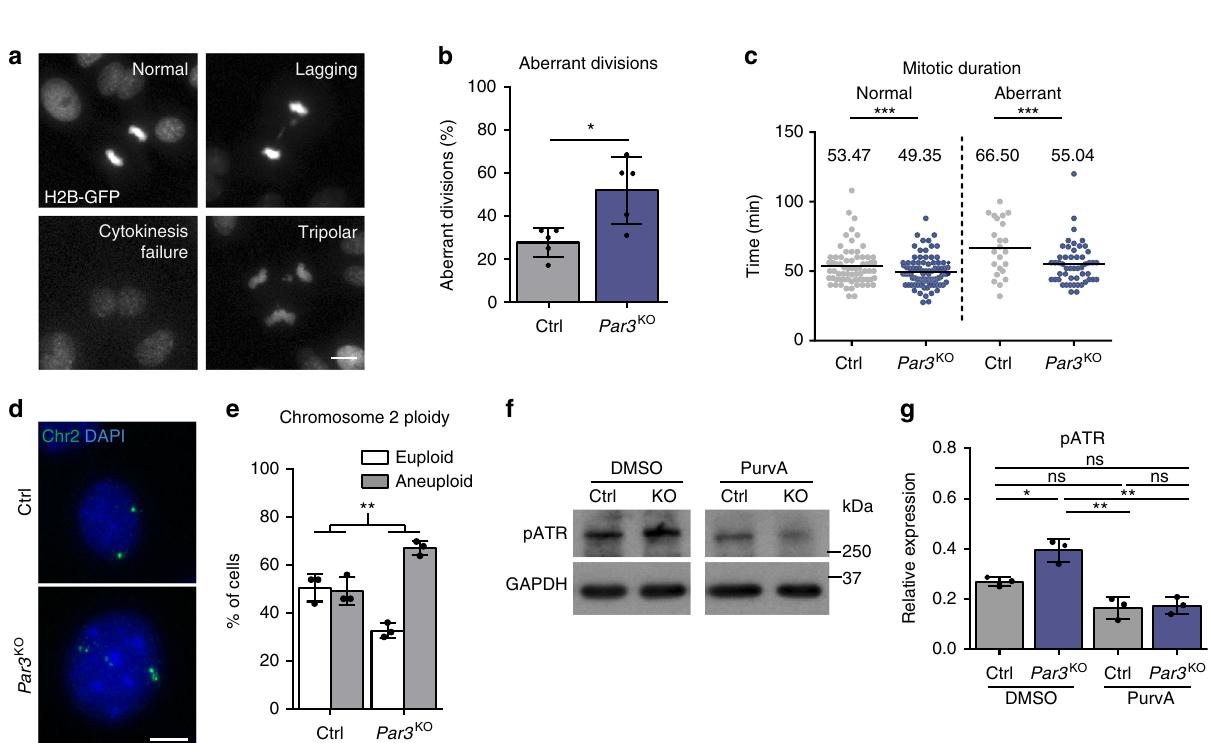
Fig. 2 Par3 ensures mitotic fi delity and genome integrity of keratinocytes. a Representative images of mitotic aberrations observed in time-lapse microscopy of H2B-GFP-expressing keratinocytes (H2B-GFP in gray). Scale bar: 10 µ m. b Quanti fi cation of aberrant cell divisions in primary Par3 KO and control keratinocytes observed in time-lapse microscopy. n = 5 independent experiments, paired two-tailed Student ’ s t -test, * p = 0.0438, mean ± SD. c Quanti fi cation of mitotic duration (Ctrl/normal n = 69 cells, Par3 KO/normal n = 95 cells, Ctrl/aberrant n = 23 cells, Par3 KO/abnormal n = 51 cells; in all cases pooled from three independent experiments). For statistical analysis a nonlinear mixed model using RStudio software was employed, yielding *** p < 0.001. Bar represents mean. d Representative images of iFISH probes targeting chromosome 2. Scale bar: 10 µ m. e Quanti fi cation of d . n = 3 independent experiments, ** p = 0.0028, mean ± SD; two-way ANOVA/Sidak ’ s multiple comparisons test. f Immunoblot analysis of ATR activation in primary Par3- de fi cient and control keratinocytes after treatment with Cdk1 inhibitor Purvalanol A (10 µ M). GAPDH served as loading control. g Quanti fi cation of f . pATR levels were fi rst normalized to GAPDH and then expressed as relative values. n = 3 independent experiments; mean ± SD; two-way ANOVA/Tukey ’ s multiple comparisons test * p = 0.0459, ** p = 0.0026 ( Par3 KO/DMSO vs. Ctrl/PurvA), ** p = 0.0032 ( Par3 KO/DMSO vs. Par3 KO/PurvA). Cropped immunoblot data are shown. iFISH interphase fl uorescence in situ hybridization, Ctrl control, KO Par3 KO, PurvA Purvalanol A, ns non-signi fi Par3 in wild-type keratinocytes (Fig. 3e – g). In agreement, Fig. 4a, b), supporting a role for cortical Par3 upstream of myosin immunoblotting demonstrated a signi fi cant overall reduction in activation. Importantly, active RhoA (RhoA-GTP), but not phosphorylation of MLC2 and of the actin-binding proteins total RhoA, was signi fi cantly decreased following Par3 inactiva- ezrin – radixin – moesin (pERM) (Fig. 3h, i). Moreover, both re- tion (Fig. 3j, Supplementary Fig. 6a, b). This was further asso- expression of Par3-full length (Par3-FL) and membrane-targeted ciated with increased protein expression of the Rho-inhibiting Par3 (Par3-CAAX) were suf fi cient to restore junctional MLC2 protein p190-RhoGAP (Fig. 3k, l). Consistent with impaired phosphorylation in Par3 KO keratinocytes (Supplementary Rho/myosin activity in primary Par3 KO keratinocytes,